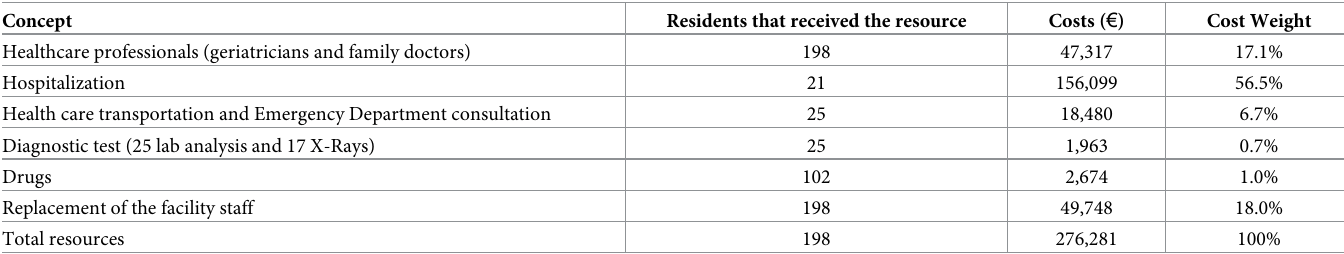
Table 4. Costs of the intervention from March, 6 th to April 5 th 2020 in facility A.